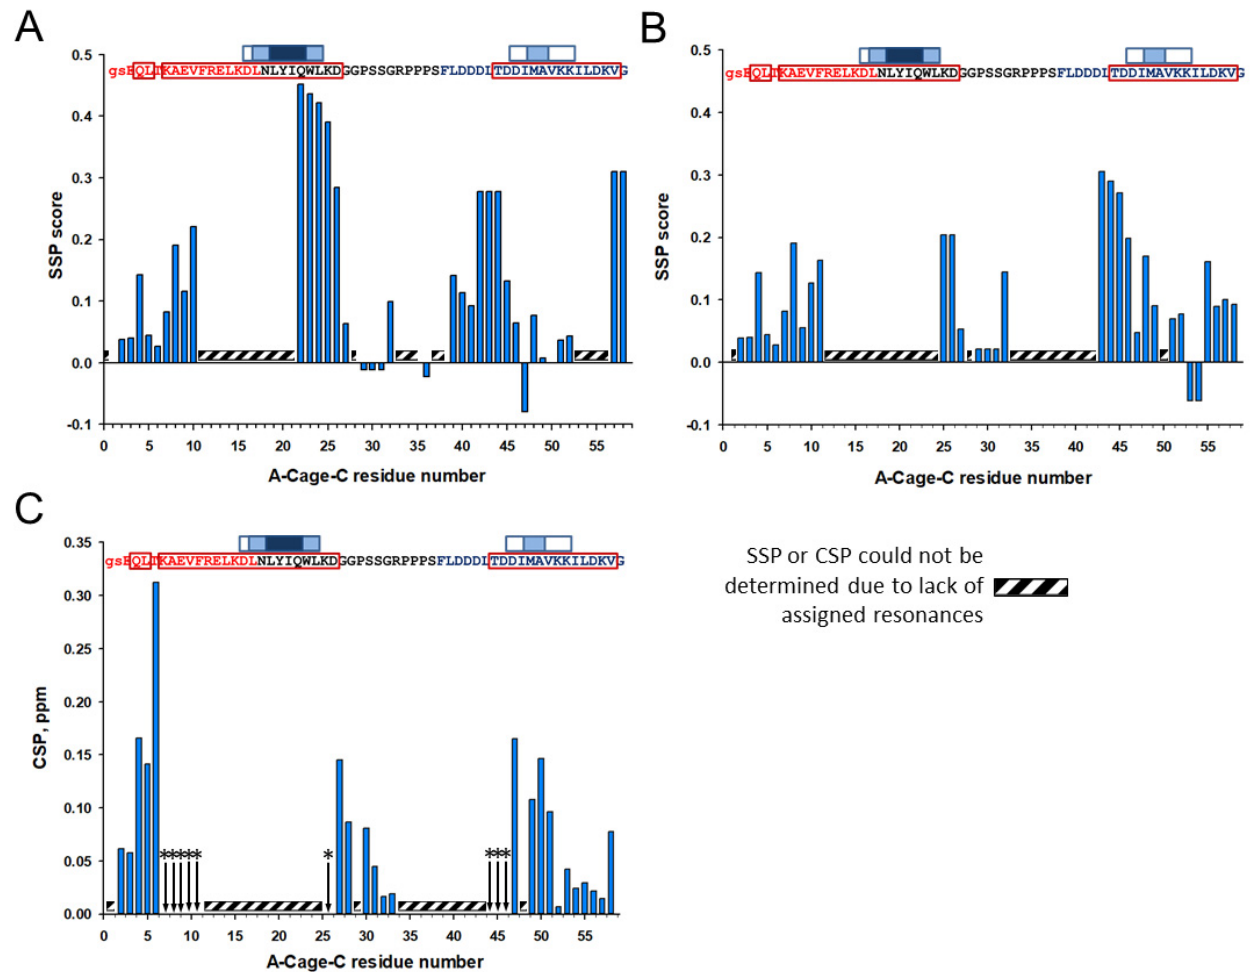
Figure 6. Effects of pH changes and addition of bicelles. ( A ) Secondary structure propensity (SSP) score calculated based on the assigned residues of A-Cage-C at pH 7.0 in the absence of bicelles. ( B ) SSP score calculated based on the assigned residues of A-Cage-C at pH 4.5 in the absence of bicelles. ( C ) Chemical shift perturbation (CSP) analysis obtained from comparison of the A-Cage-C peptide resonance assignment in the absence and presence of bicelles at binding conditions (pH 4.5). Amino acids at positions indicated by the arrows with stars (*) showed signal broadening beyond detection upon binding to bicelles. Panel insets: A-Cage-C Sequence information aligned with horizontal axis residue number. Red, black, and blue capital letters indicate Helix A, Trp-Cage, and Helix C motifs; lower case letters indicate two remaining residues from TEV cleavage; Red frames indicate predicted helices; White, light blue and dark blue boxes indicate increasing AMYLPRED2 consensus. For further details, see Figure 2 and Materials and Methods.